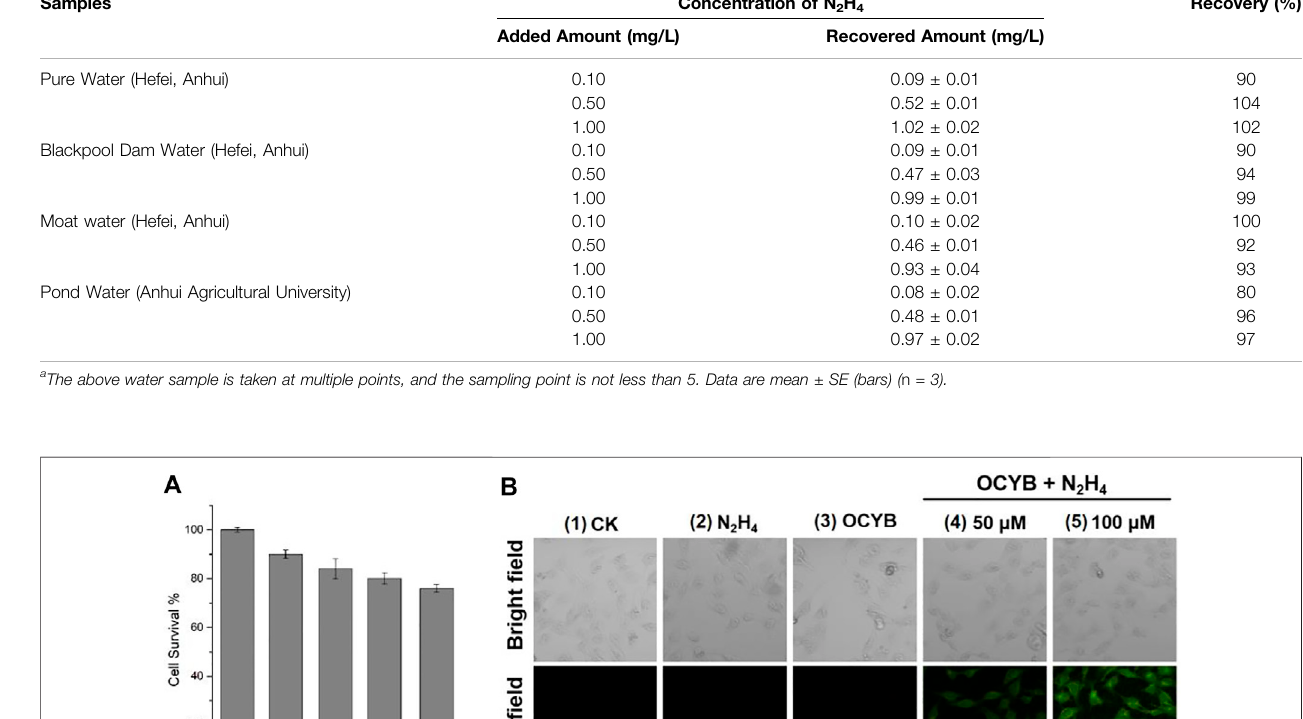
TABLE 1 | Determination of N 2 H 4 in real water samples. Samples